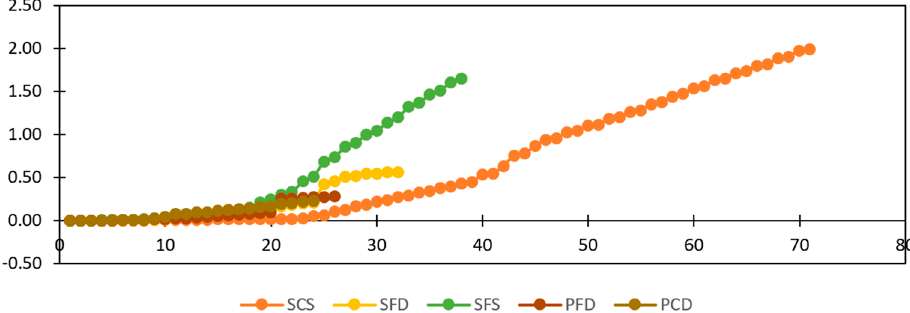
Figure 16. Cumulative energy dissipation.